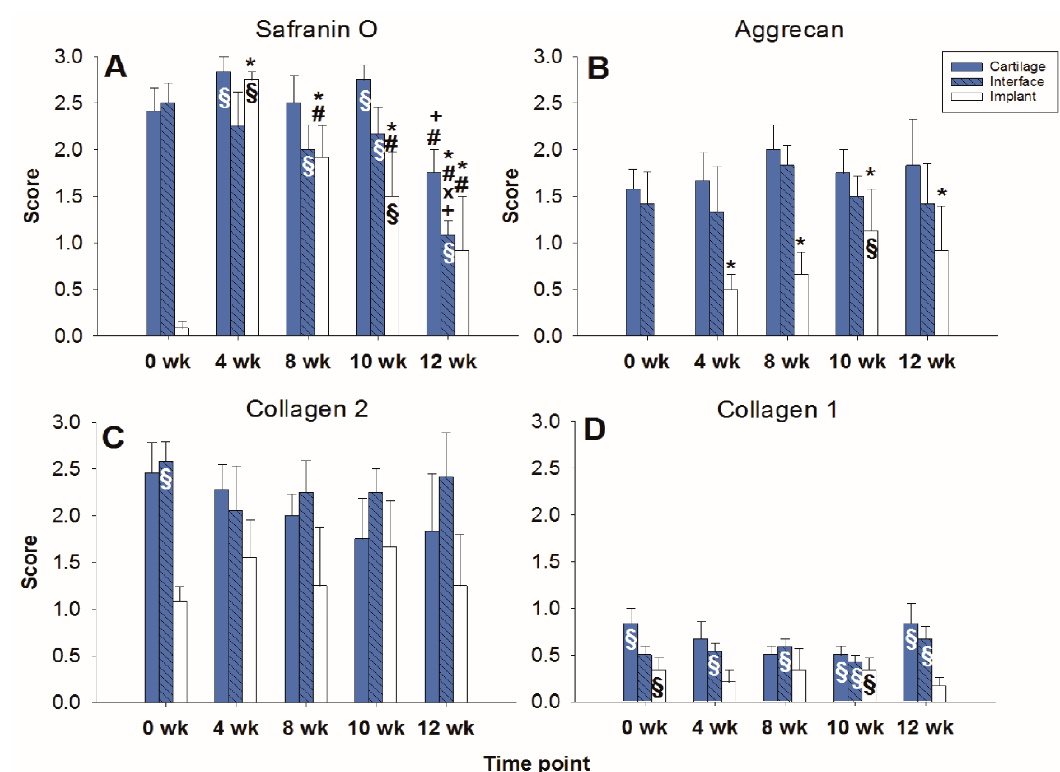
Figure 6. Semiquantitation of the (immuno)staining for Safranin O ( A ), aggrecan ( B ), collagen 2 ( C ), and collagen 1 ( D ) in “host” cartilage, cartilage–implant interface, and PGA implant (cell-loaded) after different periods of in vitro culture. Score: 0 = no staining, 1 = weak staining, 2 = moderate staining, 3 = strong staining; means +/ − standard error (SEM) of the mean; symbols show p ≤ 0.05 versus: * 0 weeks; # 4 weeks; x 8 weeks; or + 10 weeks; § versus cell-free.